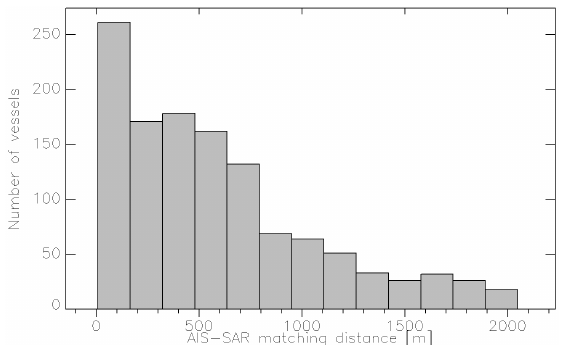
Figure 4. Distribution of the AIS-SAR matching distances for the English Channel case